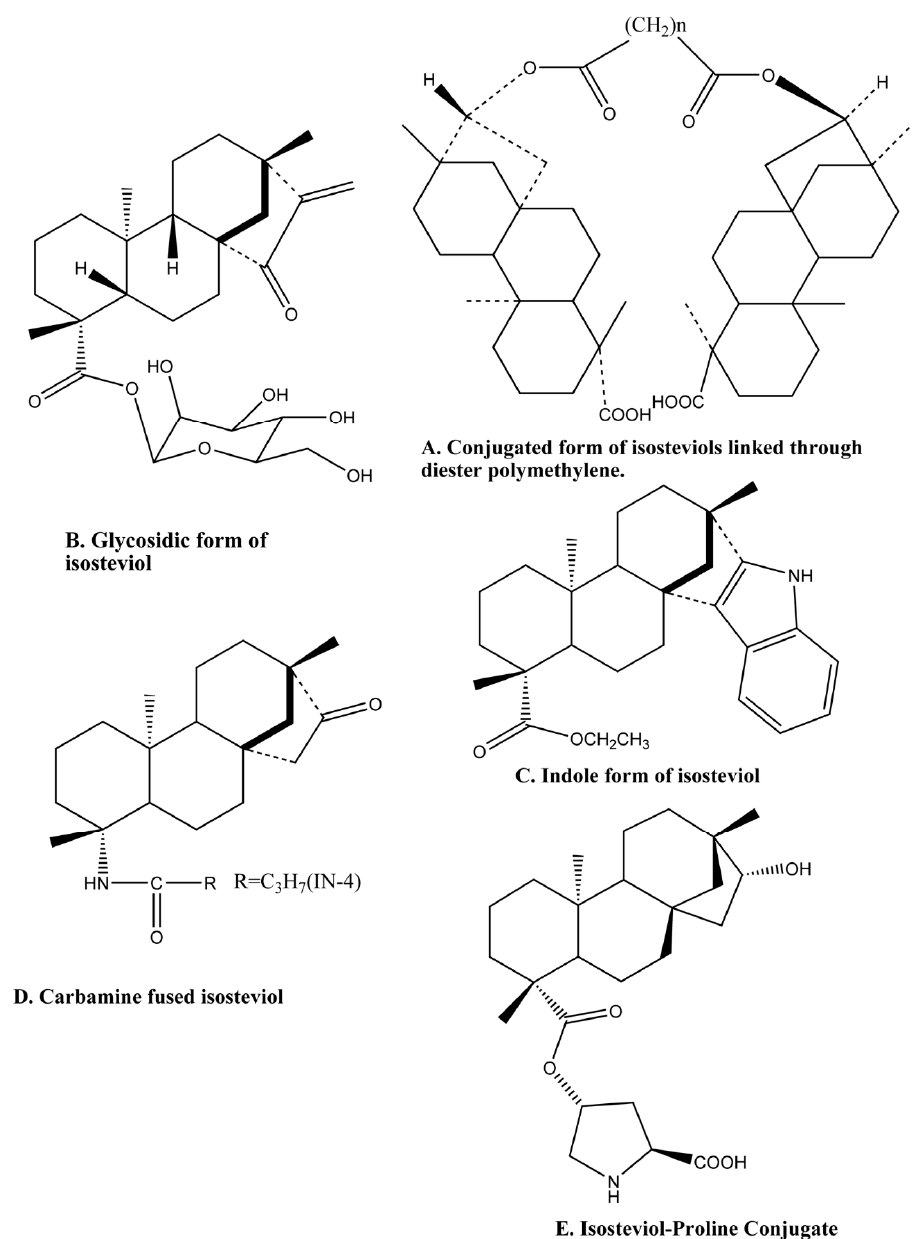
Figure 3. Different analogues of isosteviol.